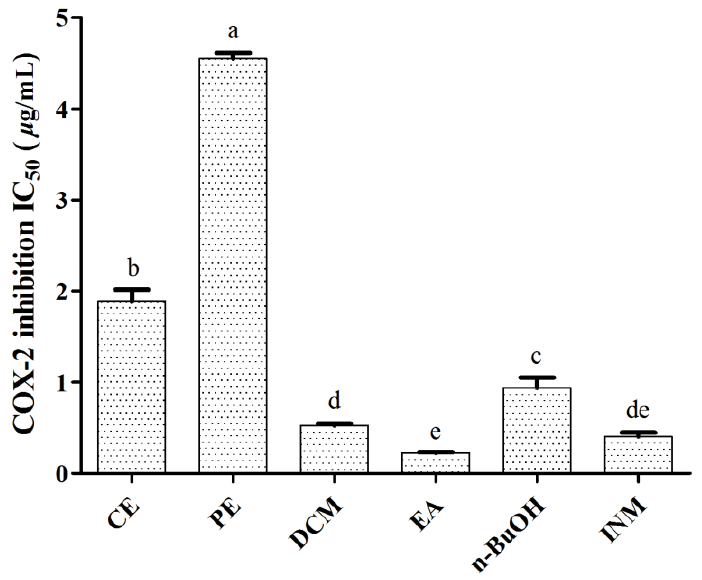
Figure 1. COX-2 inhibition activities of CE, PE, DCM, EA and n -BuOH fractions of C. spinarum . Indomethacin (INM) was used as a positive control. Data are expressed as means ± SD ( n = 3). Means labeled by different letters (a – e) are significantly different at a level of p < 0.05 ( n = 3) by one-way ANOVA DMRT.